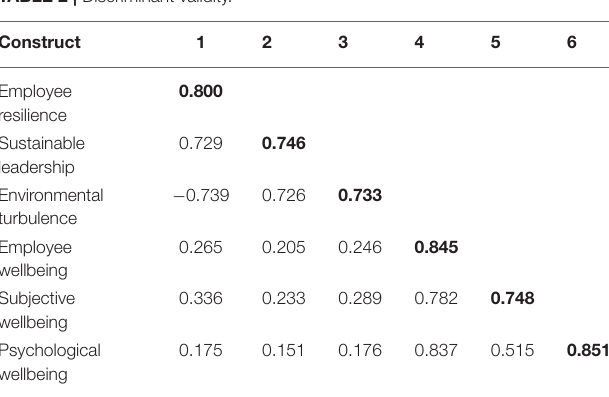
TABLE 2 | Discriminant validity.